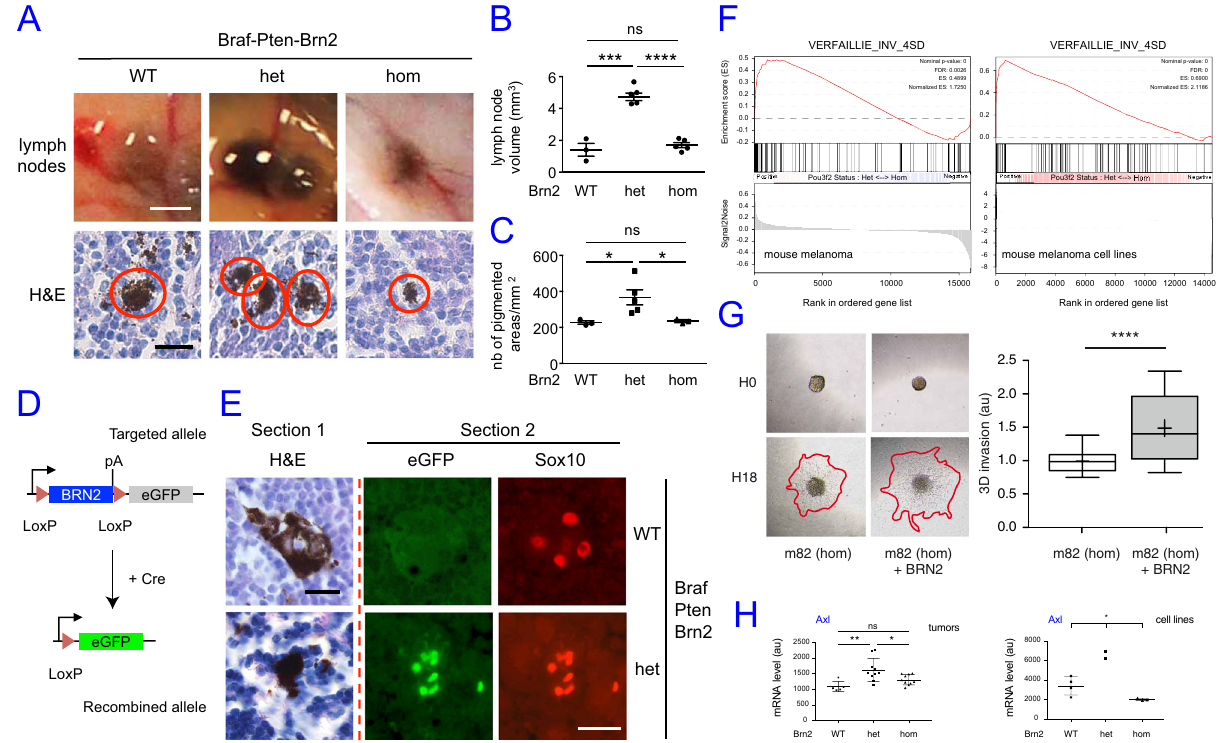
Fig. 4 Mono-allelic loss of Brn2 induces melanoma metastasis. A Upper panel: Representative photomicrographs of in situ inguinal lymph nodes (LN) of Braf-Pten-Brn2-WT/het/hom mice. Scale bar = 1 mm. The pigmented volume (mm 3 ) was estimated for each LN. Lower panel: Representative photomicrographs of haematoxylin & eosin (H&E) staining of LNs containing pigmented cells. Scale bar = 20 µ m. B Quanti fi cation of the pigmented volume of inguinal LNs in the upper panel of Figure ( A ). n = 3, 5, and 5 for WT, het, and hom. ( c ) Quanti fi cation of the pigmented areas per mm 2 of inguinal LNs in the lower panel of Figure ( A ). Pigmented areas > 50 µ m 2 were considered. n = 3, 5, and 3 for WT, het, and hom. D Scheme showing the de fl oxing strategy of Brn2 in melanocytes of the primary tumor that releases eGFP expression upon the de fl oxing of Brn2 . E Representative photomicrographs of serial LN sections of Braf-Pten-Brn2-WT and Braf-Pten-Brn2-het mice stained with H&E and the melanocyte marker Sox10. H&E staining was evaluated for one section and GFP (green channel) and Sox10 staining (red channel) evaluated for an adjacent section. Scale bar = 20 µ m. F A melanoma invasive signature was signi fi cantly enriched in the Braf-Pten-Brn2-het tumors (left) and in the Braf-Pten-Brn2-het melanoma cell lines (right) compared to their Braf-Pten-Brn2-hom counterparts. G Left: photomicrographs of m82 and m82-BRN2 mouse melanoma cells embedded as spheroids in 600 μ g/mL matrigel at t0 (H0) and 18 hrs after (H18). Right: Boxes and plots represent the area of invasion (red lines on photomicrographs) quanti fi ed with ImageJ ( n = 54 for m82 cells and n = 56 for m82-BRN2 cells). P value < 0.0001. au = arbitrary unit. h Axl mRNA is signi fi cantly overexpressed in Braf-Pten-Brn2- het melanoma and melanoma cell lines ( n = 10 and 2, respectively) compared to the Braf-Pten-Brn2-WT ( n = 5 and 4, respectively) and Braf-Pten-Brn2- hom ( n = 10 and 3, respectively) tumors. Statistical analysis was performed using the two-tailed unpaired t test for ( B ), ( C ), ( G ), and ( H ) (tumors) and an Anova test for H (cell lines). Data are presented as mean values± SEM for ( B ) and ( C ), sd for ( H ), and Box and whiskers (median, min to max) for ( G